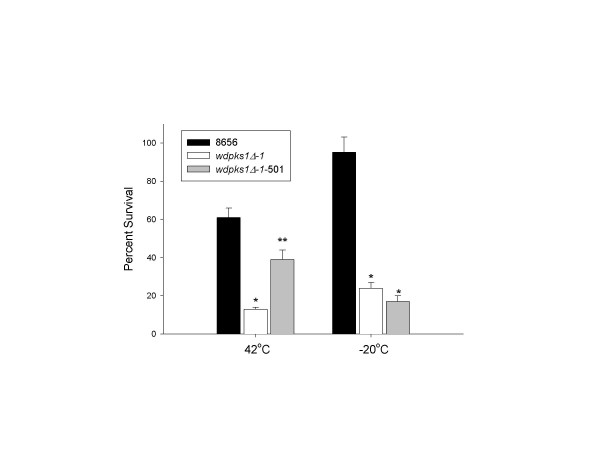
Susceptibility to heat and cold. Strain 8656, wdpks1Δ-1, and wdpks1Δ-1-501 yeast cells grown for 7 days in YPD medium at 37°C and incubated at 42°C for 2 h or -20°C overnight. Survival was compared to fungal cells incubated in PBS. Values are averages of the standard errors of the means for three measurements. *, p < 0.001 and **, p < 0.01. The experiment was repeated with similar results.